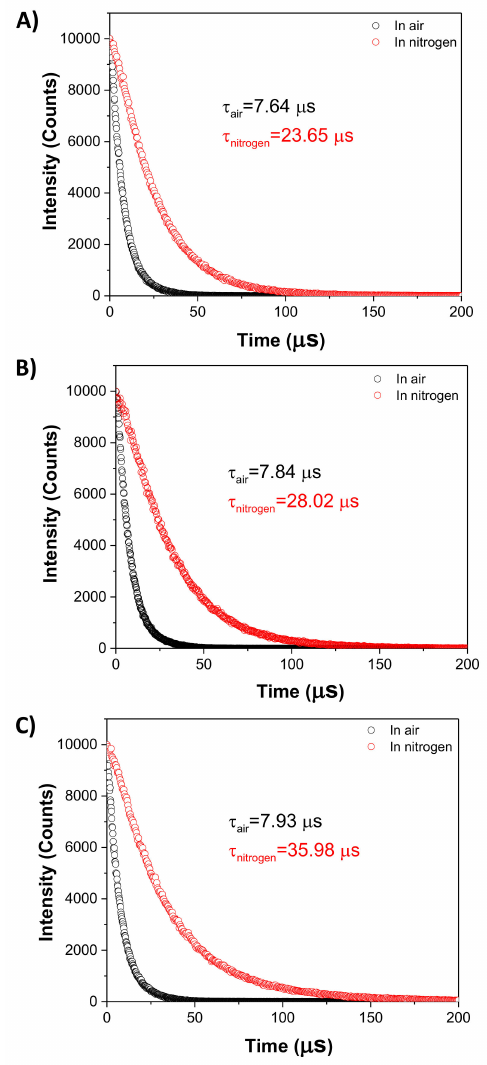
Figure 6. Phosphorescent decays ( λ ex = 405 nm) of micelles M1 ( A ), M2 ( B ), and M3 ( C ) respectively under air and nitrogen